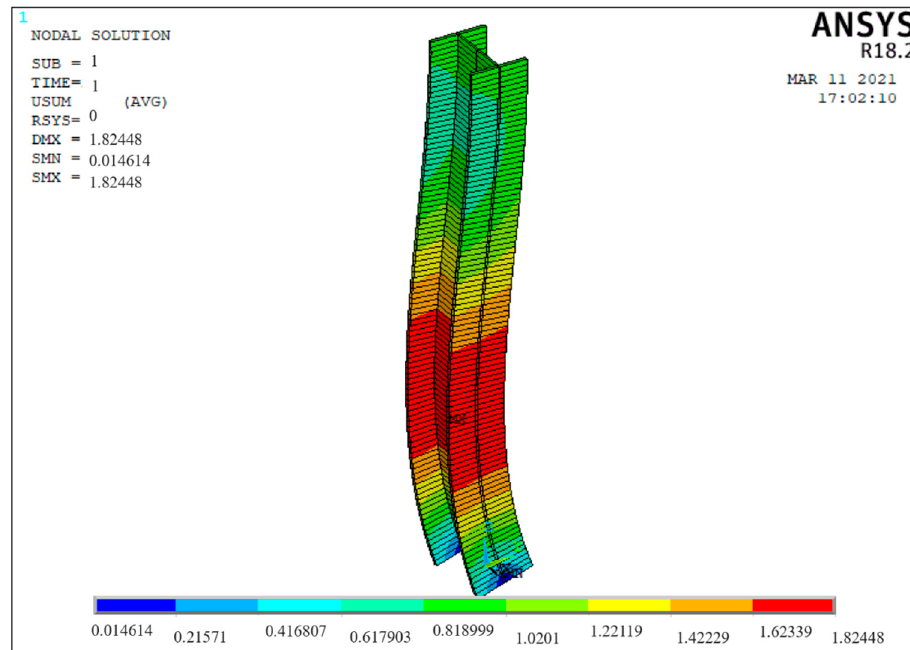
Figure 12. The total displacement of the rod of the derrick leg.